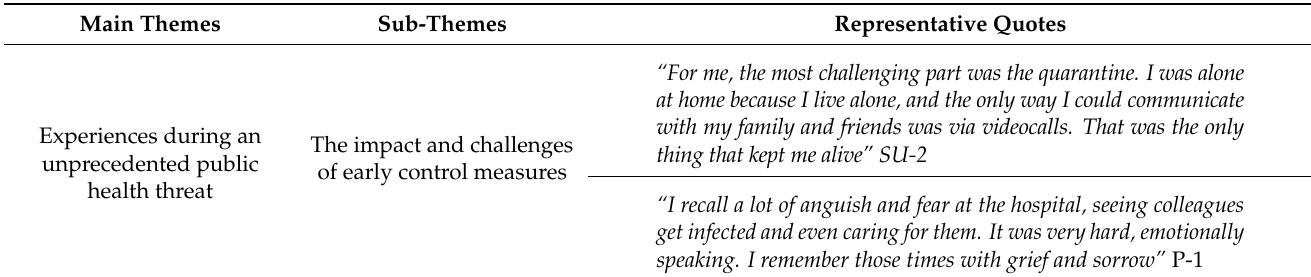
Table 2. Themes, sub-themes and representative